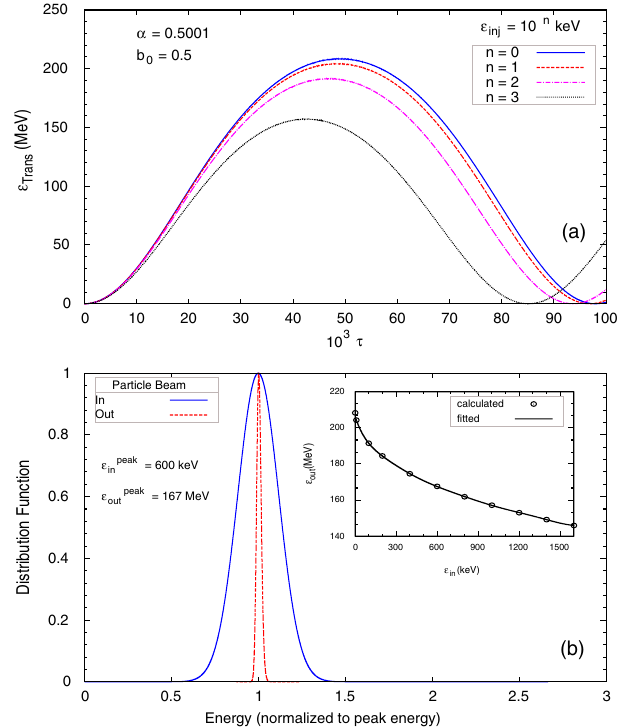
FIG. 11. Temporal evolution of the kinetic energy for different values of injection energies (a). An energy spectrum of the output beam is calculated by injecting a beam with Gaussian energy spectrum (b). The inset in (b) represents the output beam energy as a function of injection energy, circles denote the numerically measured values; however, the solid line is 10th order polynomial fit which is used in calculating the energy distribution function of output beam.